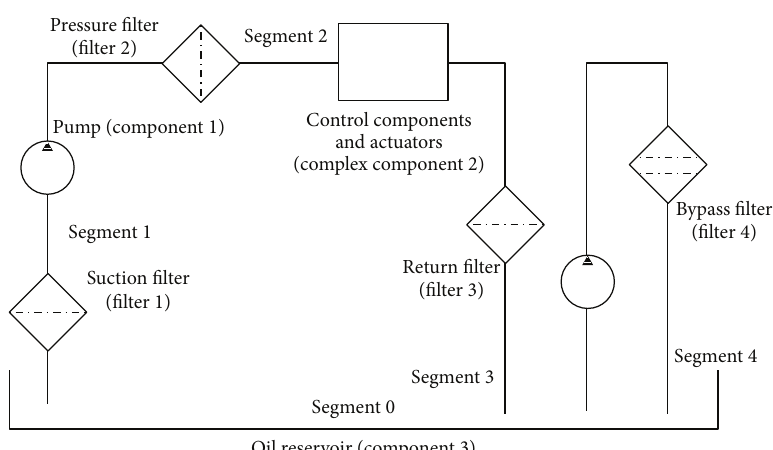
Figure 1: Framework of the ICIP model.